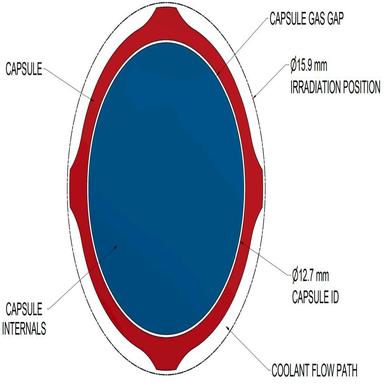
Schematic of the planar view of the standard capsule in a 15.9 mm irradiation position.